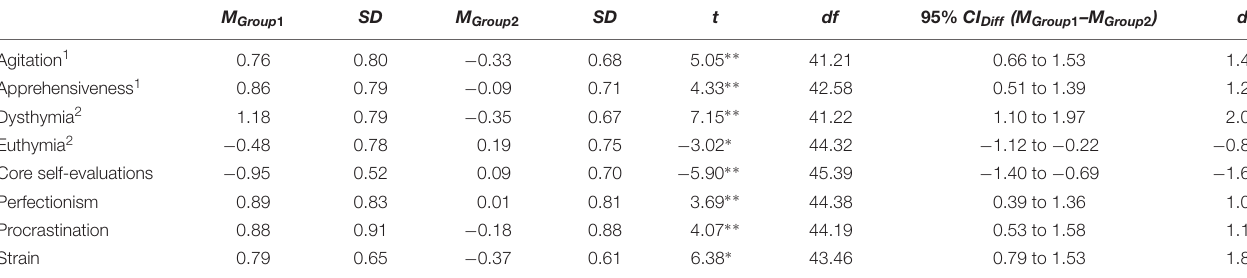
TABLE 3 | Differences in trait levels between impostor